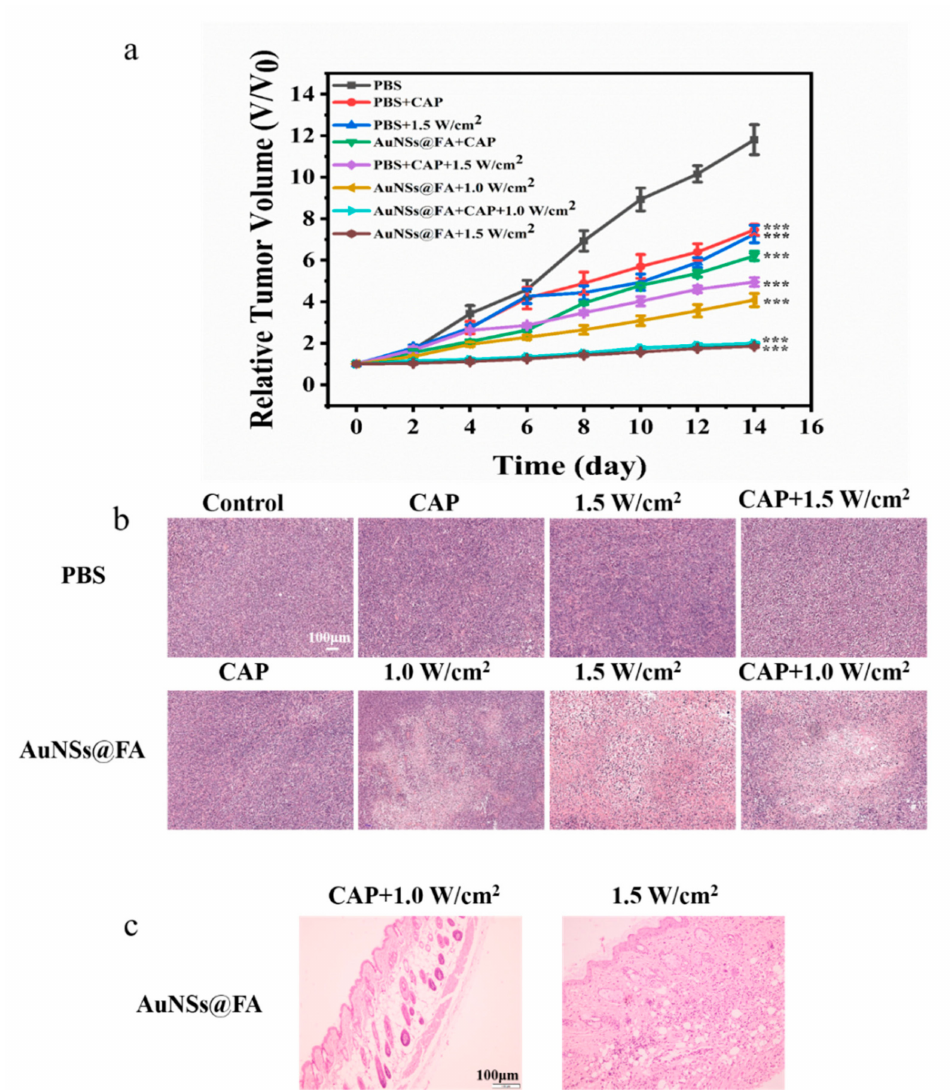
Figure 7. ( a ) Tumor volume growth curves during the 14-day therapy. ( b ) H&E slice sections of tumors with different treatments on day 14. ( c ) H&E slice sections of the skin with AuNSs@FA+1.5 W/cm 2 and AuNSs@FA+CAP+1.0 W/cm 2 treatments. *** p <0.001 were considered highly statistically